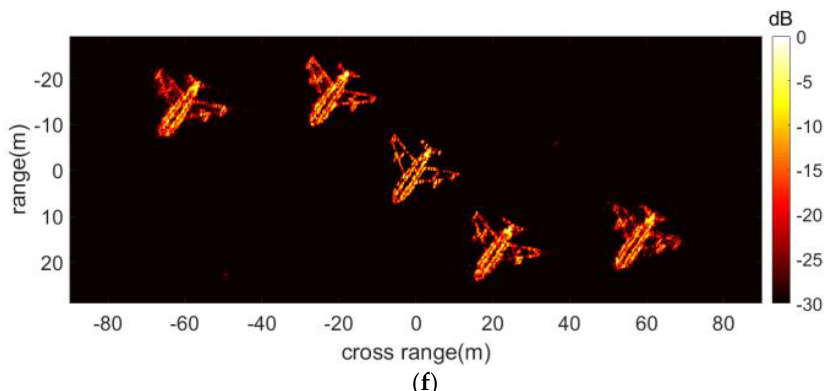
Figure 10. ISAR imaging results obtained from different methods: ( a ) RD; ( b ) RD–Keystone; ( c ) SPWVD; ( d ) HAF–ICPF; ( e ) the method of [30]; ( f ) proposed method.